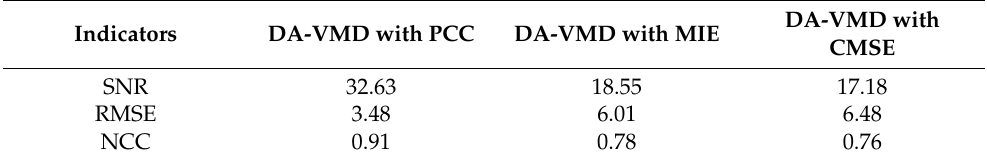
Table 6. The corresponding relationship between SNR, RMSE of radiation intensity, and NEI.